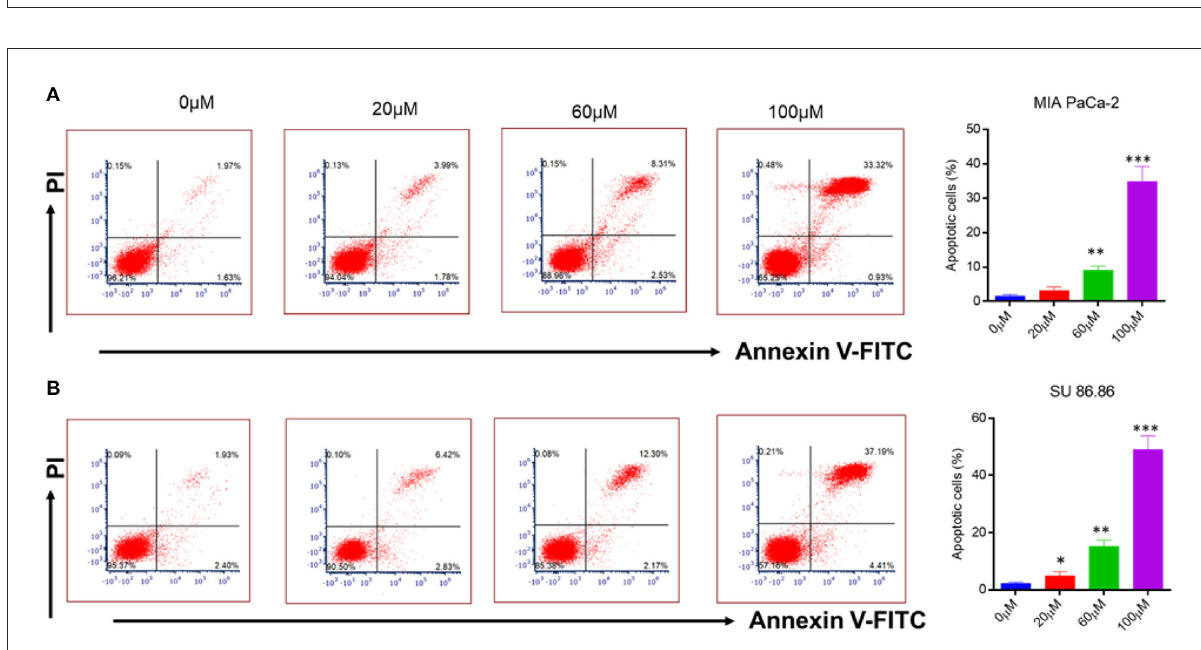
FIGURE6 Flow cytometry analysis of annexin V-FITC/PI staining (A) MIAPaCa-2 (B) SU 86.86 cell lines were cultured with increasing concentration (0–100 µ M) of EGCG for 24h. Annexin V-FITC/PI staining showed an increasing percentage of apoptotic cells with an increasing concentration of EGCG due to cell cycle inhibition. Bar graphs indicating the percentage of apoptotic cells as the concentration of EGCG increases (0–100 µ M). The data represent the mean ± SD ( n = 4) values of triplicate determinations. * p < 0.05; ** p < 0.01; *** p < 0.001 compared with the control. Data were analyzed using Flowjo software. ANOVA test was applied in the statistical analysis for group analysis.